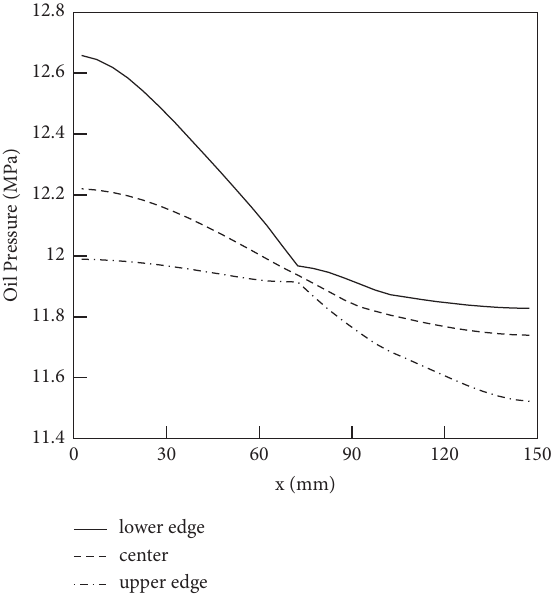
Figure 18: Oil pressure distributions in the slices of the fine grid pressure